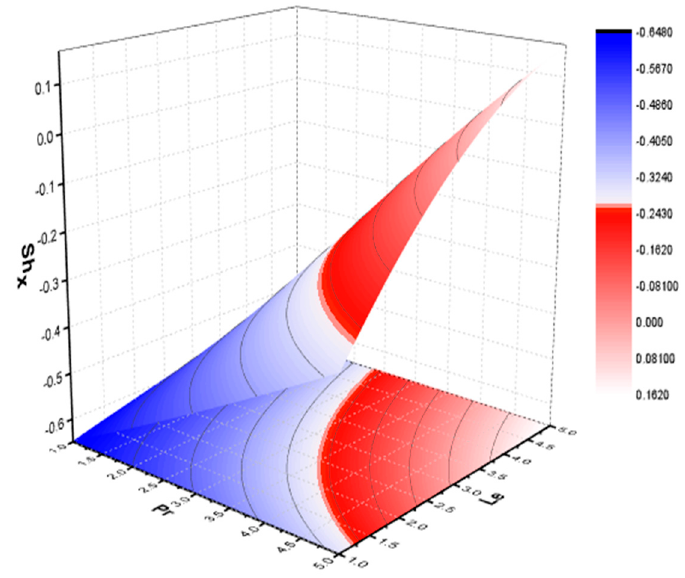
Figure 26. 3D visual of Sh x for Pr and